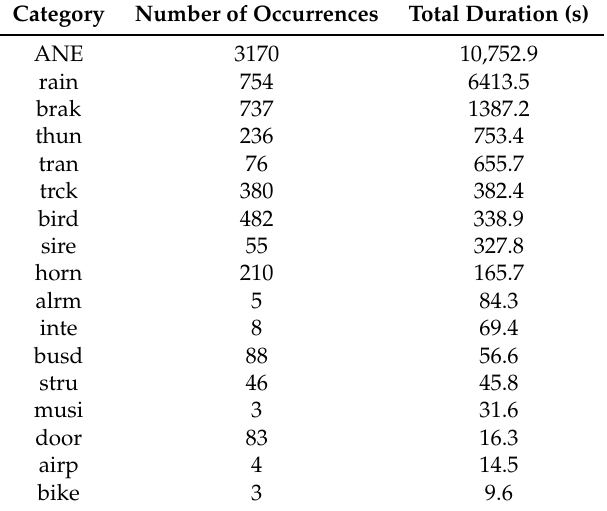
Table 1. Aggregated ANE occurrences and their total duration distribution per category.